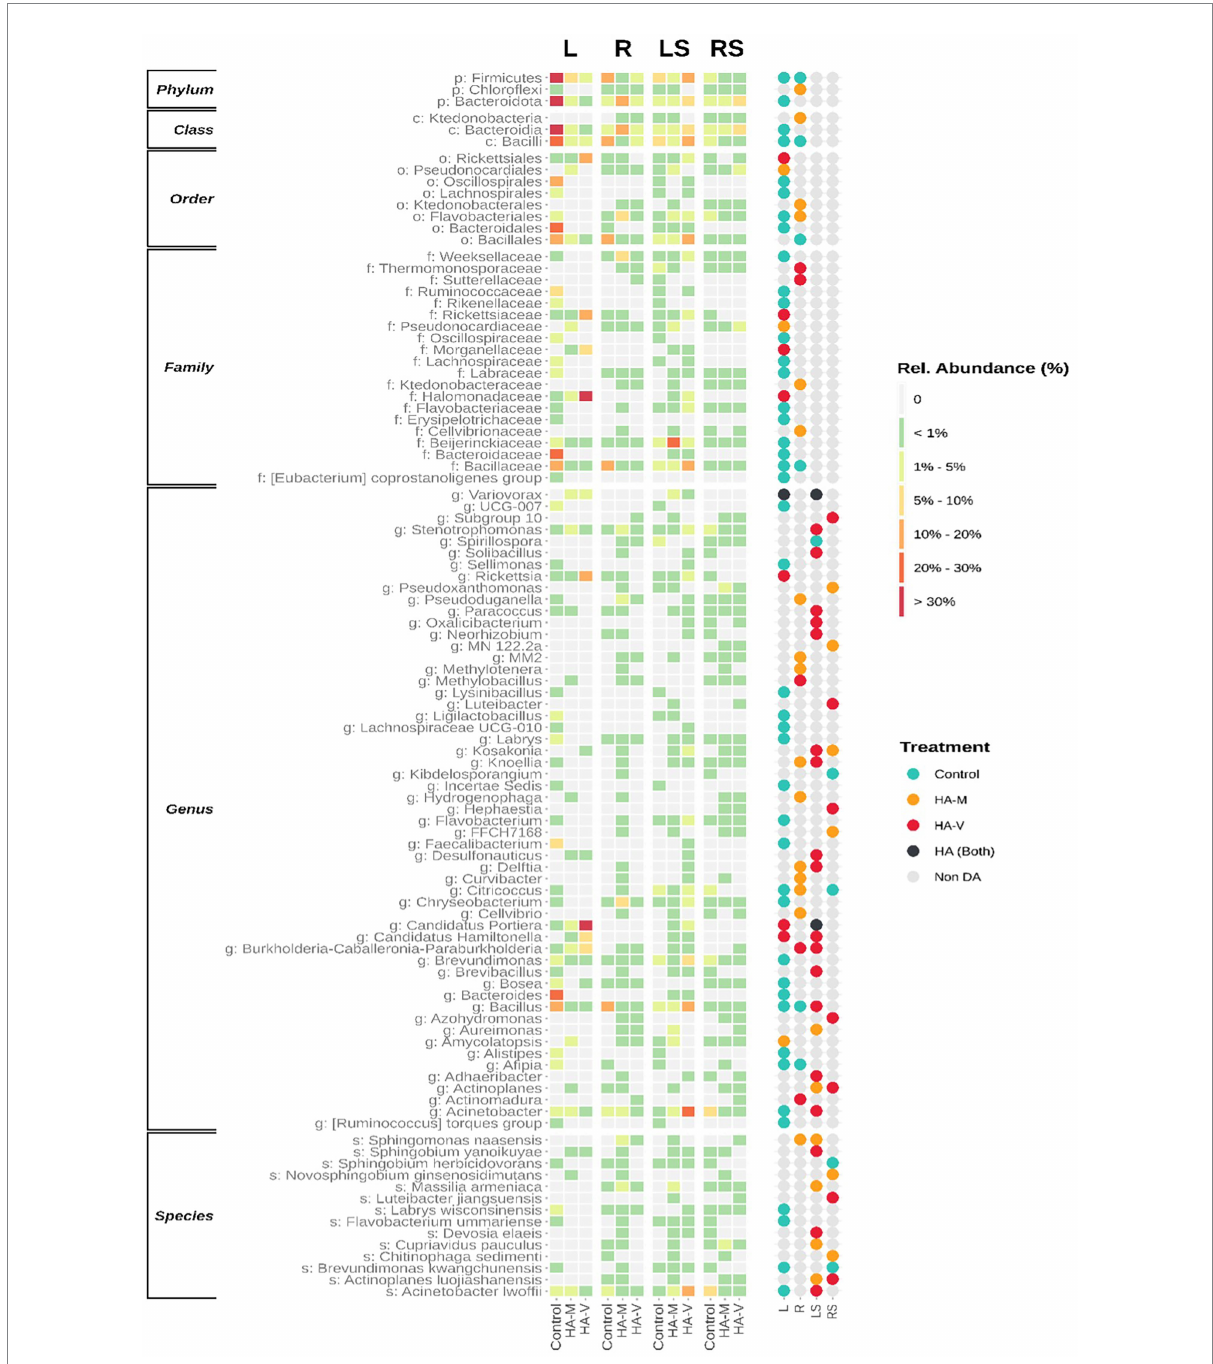
FIGURE 4 Differently abundant (DA) bacterial taxa. Both levels are presented ordered by the sum of relative abundances. The heatmap (left) demonstrates the relative abundance of taxa in leaves (L), roots (R), stressed leaves (LS), stressed roots (RS) by applying millicompost humic acid (HA-M), vermicompost humic acid (HA-V) and without application of HA (control). The dot plot (right) reveals in which niche differences in abundance between plant materials